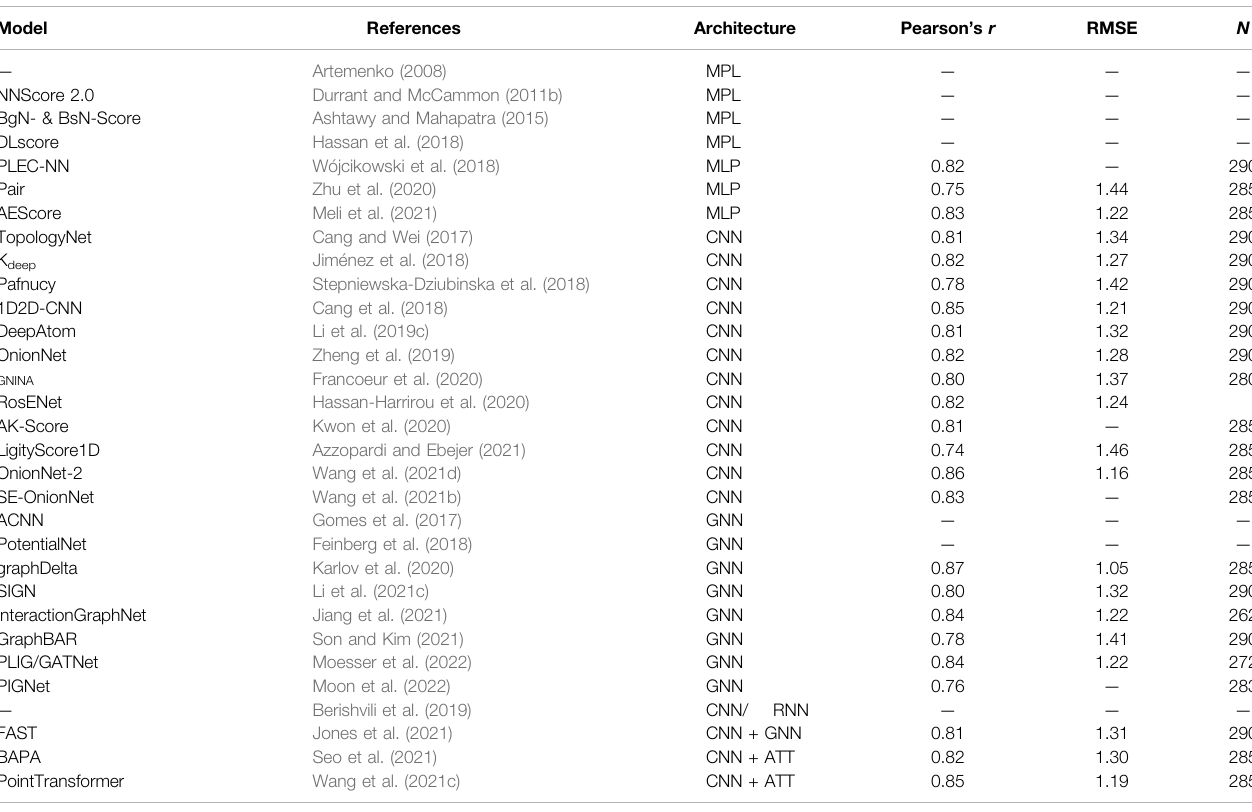
TABLE 2 | Non-exhaustive list of deep learning architectures for protein-ligand binding af fi nity prediction and their performance on the CASF-2016 scoring benchmark (if available). MLPs are included regardless of the number of hidden layers. Some methods are described in multiple publications and the ones referenced in this table are theoneswherethemodelhasbeenevaluatedonthePDBbindCoreset2016/CASF-2016set(ortheoriginalpublication,ifthisevaluationisnotavailable).Thebestresult(the highest Pearson ’ s r) isreported. Different publications might use slightly different custom variations of the CASF-2016 benchmark and the overlap between training and test setsmightbetakenintoaccountindifferentways.Wereferthereadertotheoriginalpublicationsfordetails,butwealsoreportthenumber,N,ofsystemsinthetestsetto outline possible differences. RMSEs are expressed in pK units.